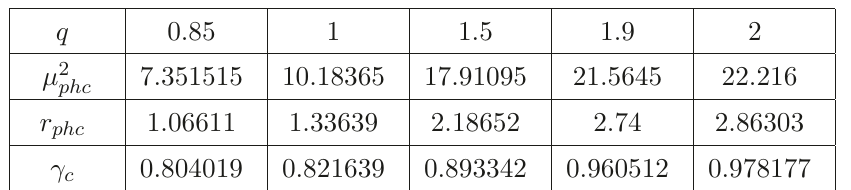
Table 1. The critical quantities in r ph